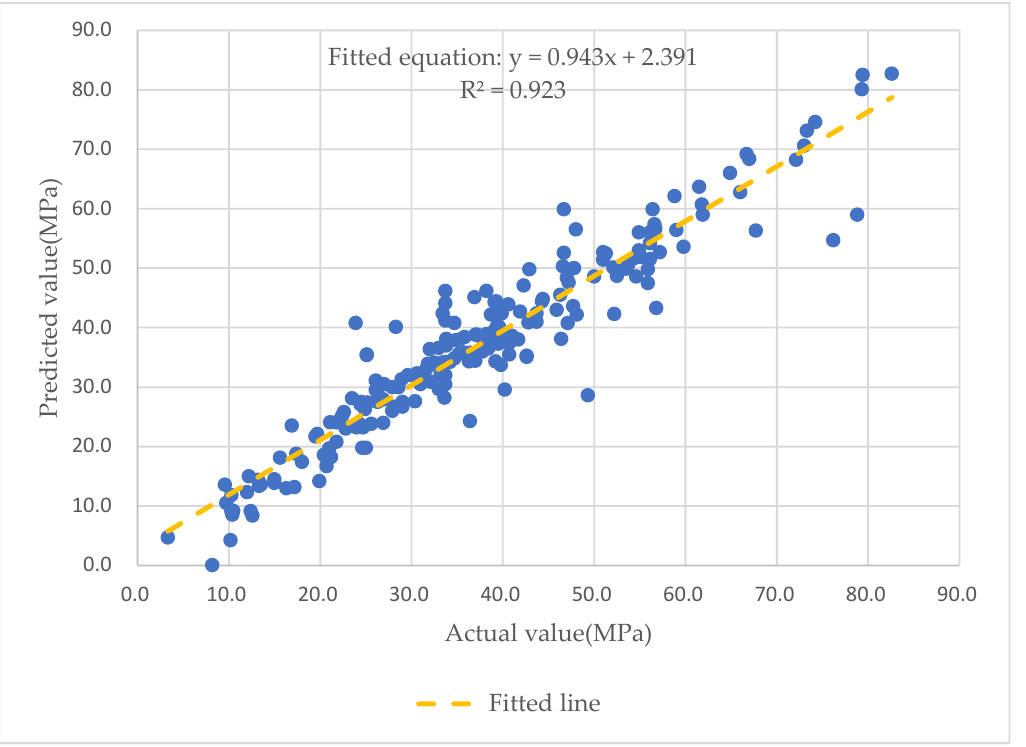
Figure 13. Relationship between tested and predicted compressive strength in the validation set.